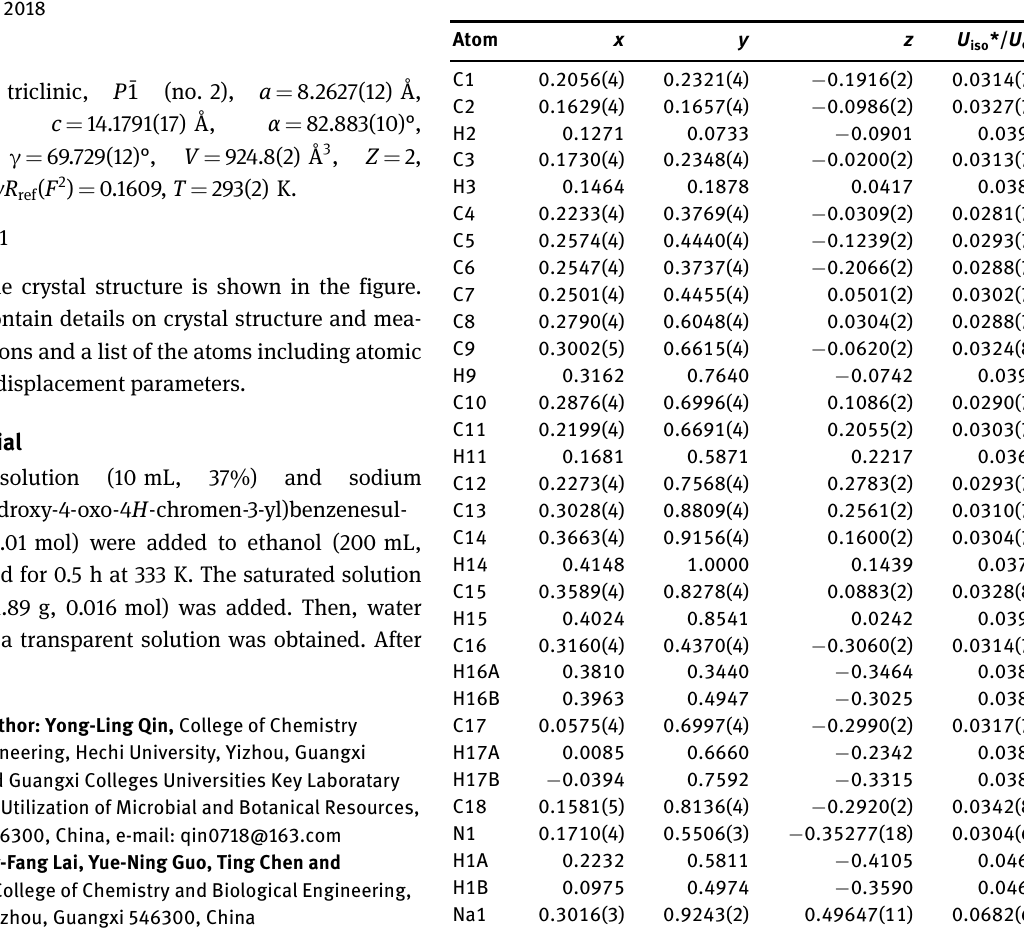
Table 2: Fractional atomic coordinates and isotropic or equivalent isotropic displacement parameters (Å 2